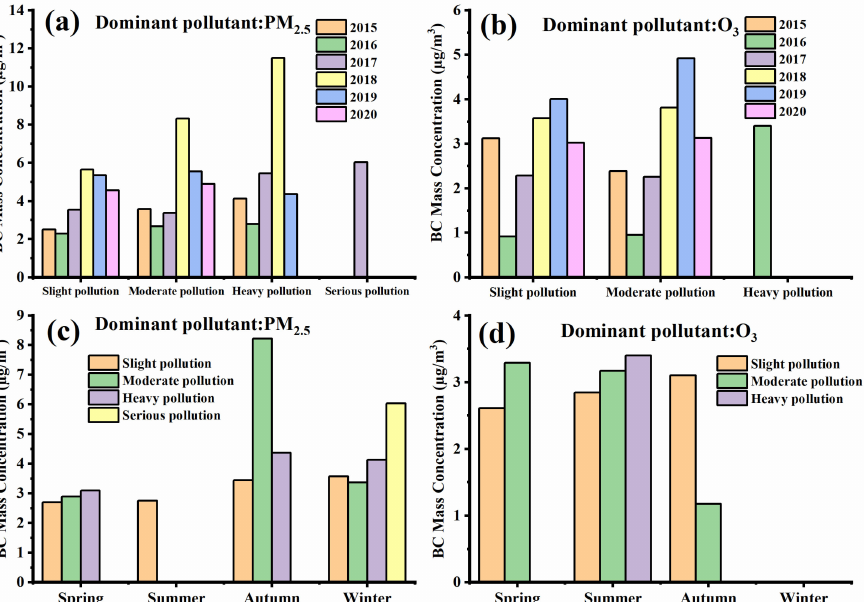
Figure 3. ( a ) Annual variations in BC mass concentrations at different air quality levels for the dominant pollutant PM 2.5 in 2015–2020; ( b ) Annual variations in BC mass concentrations at dif- ferent air quality levels for the dominant pollutant O 3 in 2015–2020; ( c ) Seasonal variations in BC mass concentrations at different air quality levels for the dominant pollutant PM 2.5 in 2015–2020; ( d ) Seasonal variations in BC mass concentrations at different air quality levels for the